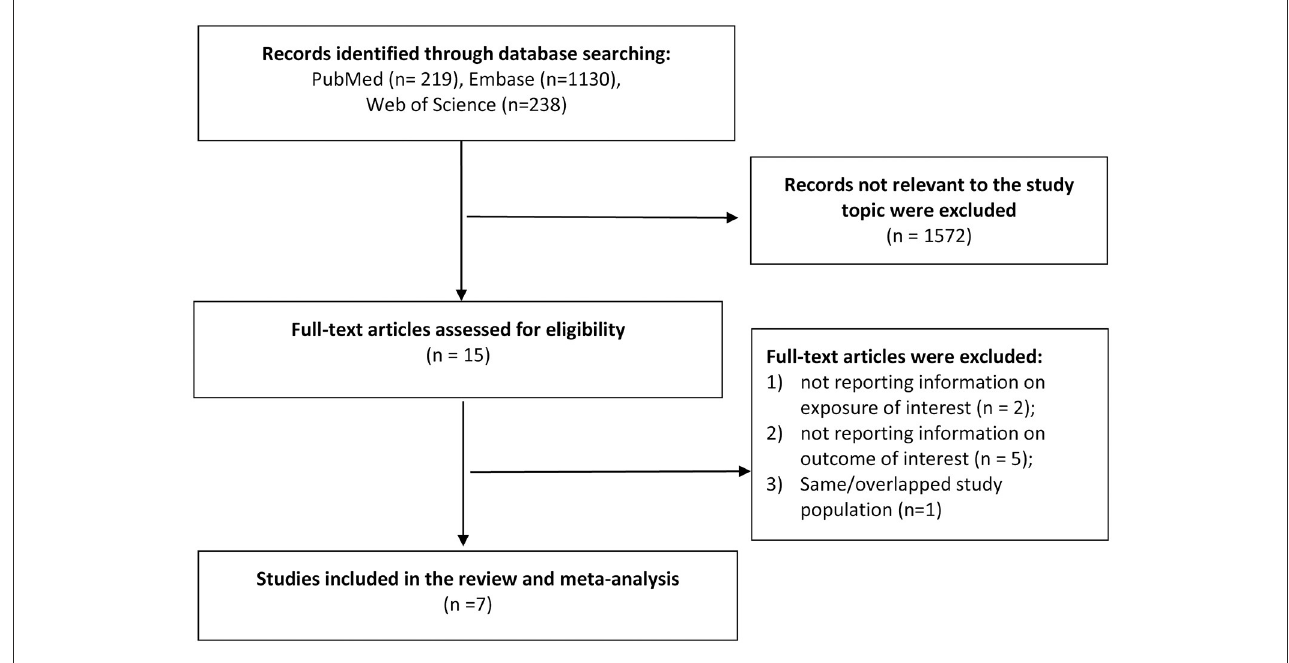
FIGURE1 Flow diagram of study selection in the